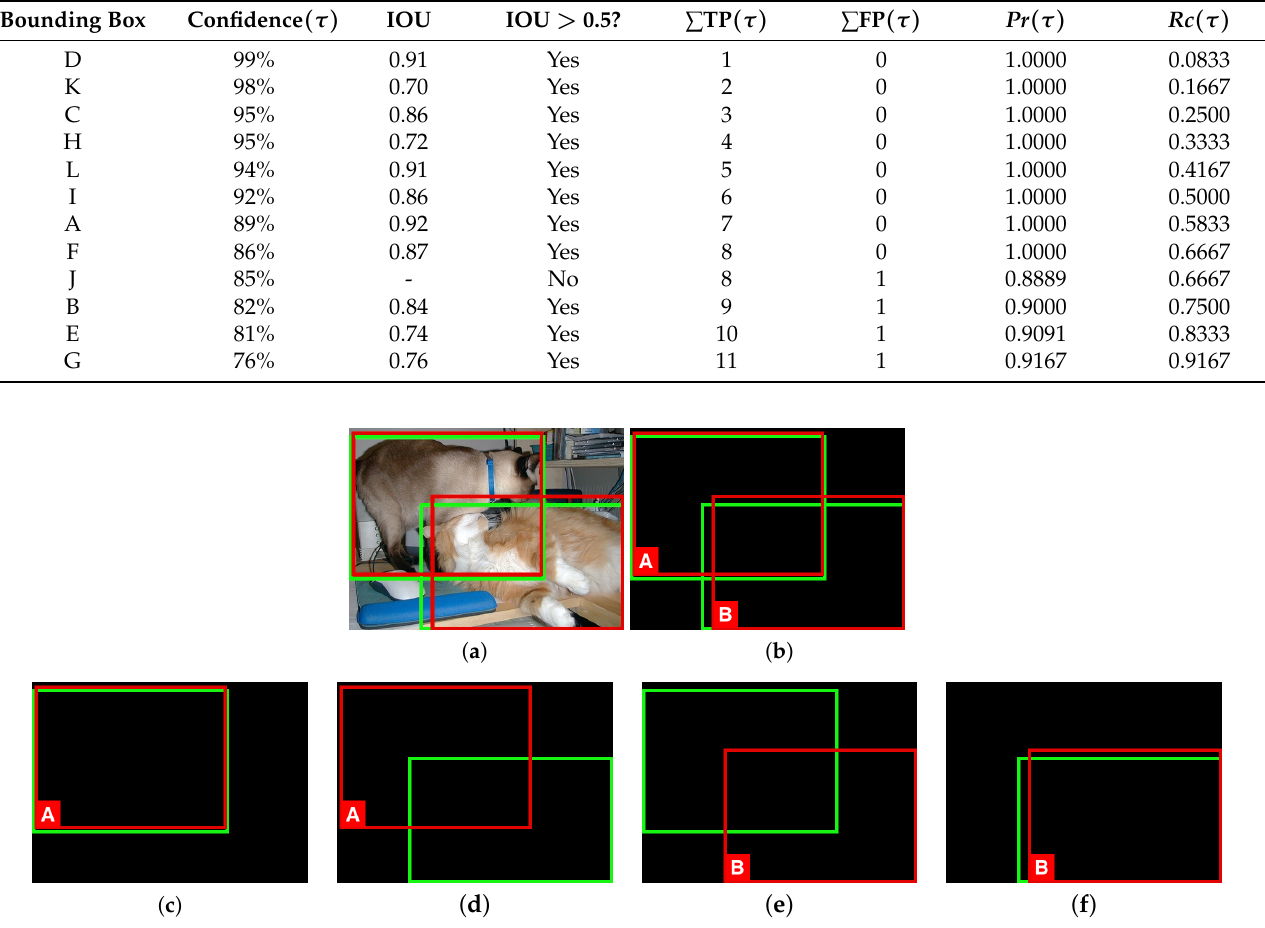
Figure 4. Particular cases showing detected bounding boxes overlapping multiple ground truths. ( a ) Original image with predicted (red) and ground-truth (green) bounding boxes. ( b ) Bounding boxes only. ( c , d ) Possible overlaps of the first ground truth. ( c ) Detection ‘A’ overlapping the first ground truth with IOU=.92. ( d ) Detection ‘A’ overlapping the second ground truth with IOU=.20. ( e , f ) Possible overlaps of the second ground truth. ( e ) Detection ‘B’ overlapping the first ground truth with IOU=.19. ( f ) Detection ‘B’ overlapping the second ground truth with